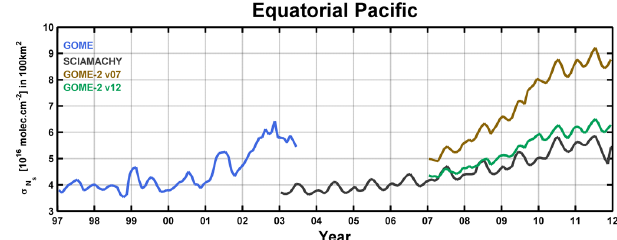
Fig. 3. H 2 CO slant column standard deviation scaled to a pixel size of 10 × 10km 2 , retrieved from GOME, SCIAMACHY and GOME- 2 over the equatorial Pacific. Two versions of GOME-2 results are shown: the initial retrieval settings (v07) and the improved settings (v12, see text for details).